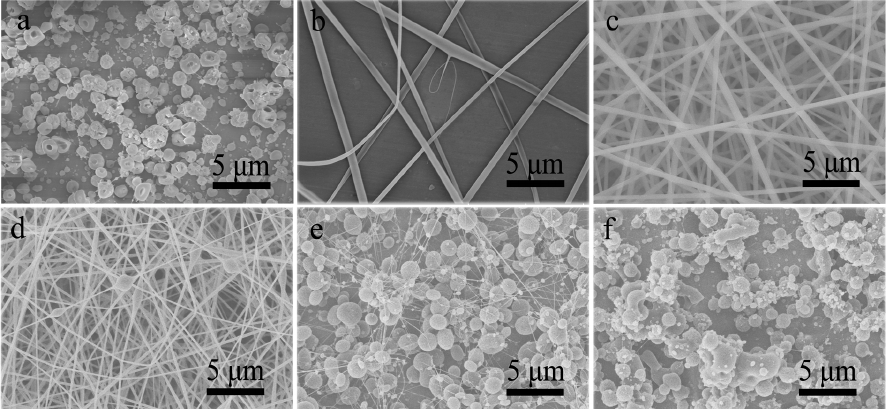
Figure 2. SEM images of resultant products prepared by single-nozzle electrospraying or electrospinning of ( a ) CA-D solution, ( b ) CA-A solution and ( d – f ) CA-AD solutions with different acetone-to-DMAc ratios of ( c ) 2/1, ( d ) 1/2, ( e ) 1/4 and ( f ) 1/8, respectively.